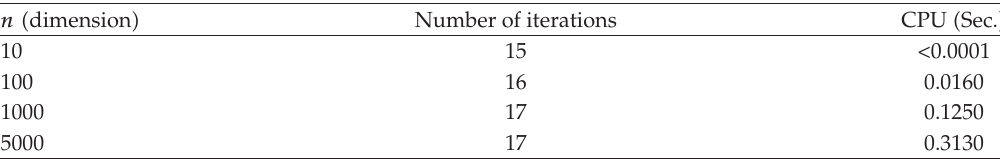
Table 9: Results for Example 6.3 using EG type HRP